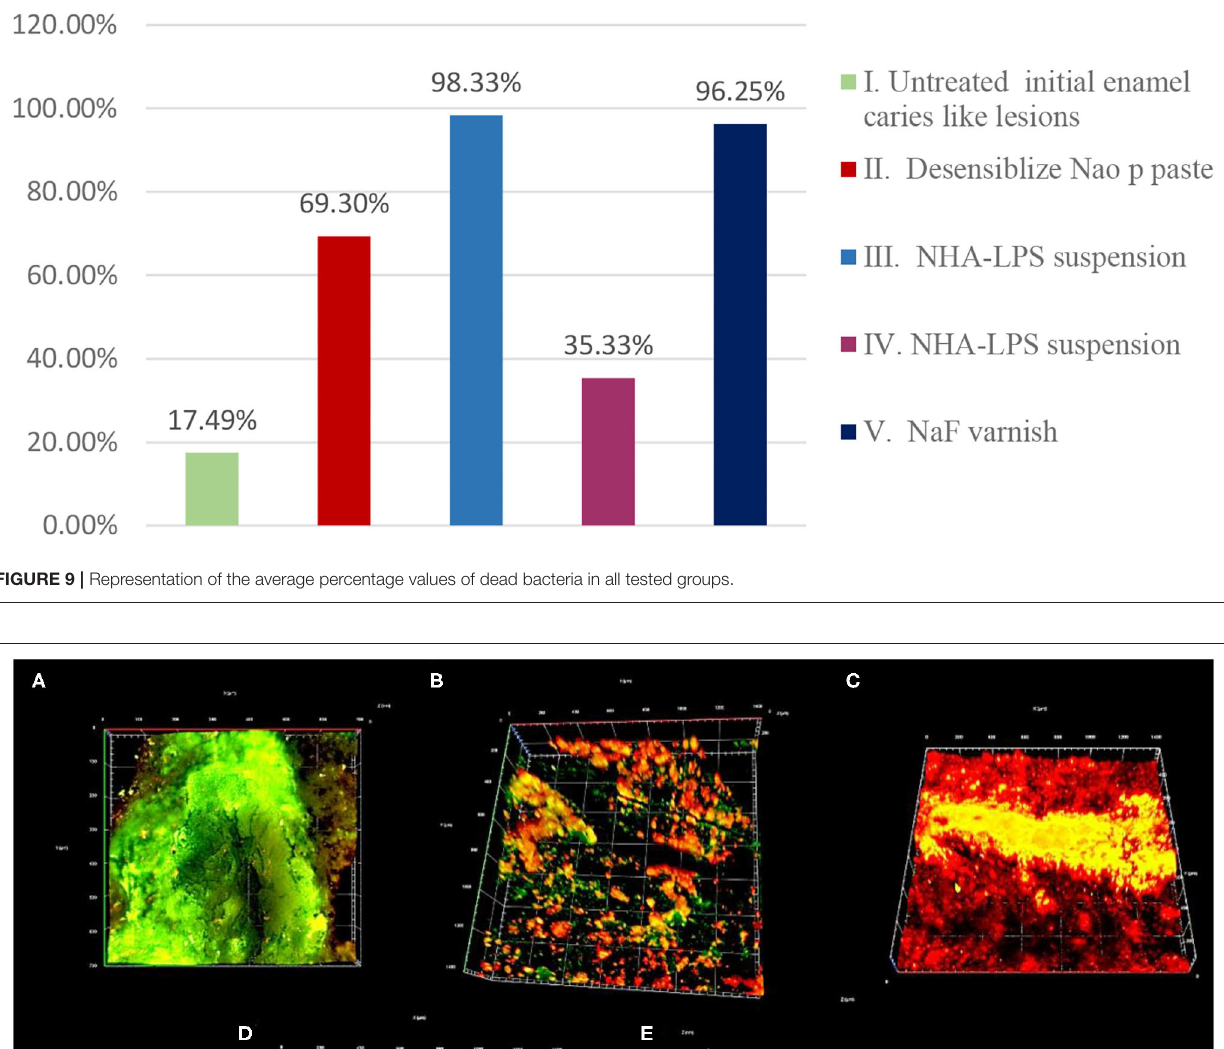
NaF. Last, this powder was characterized by very low cost, safe, the antibacterial, antibiofilm, and remineralizing effect of NHA-